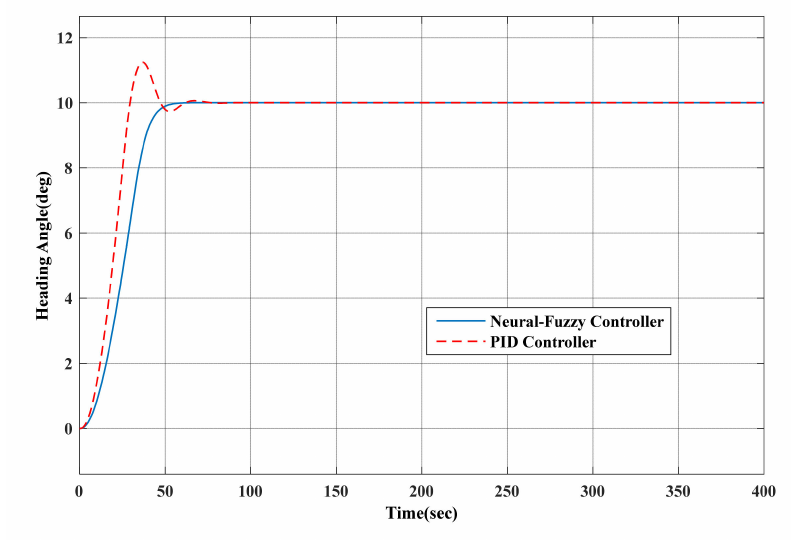
Figure 6. Heading response of the neuro-fuzzy and PID controllers with model perturbation.